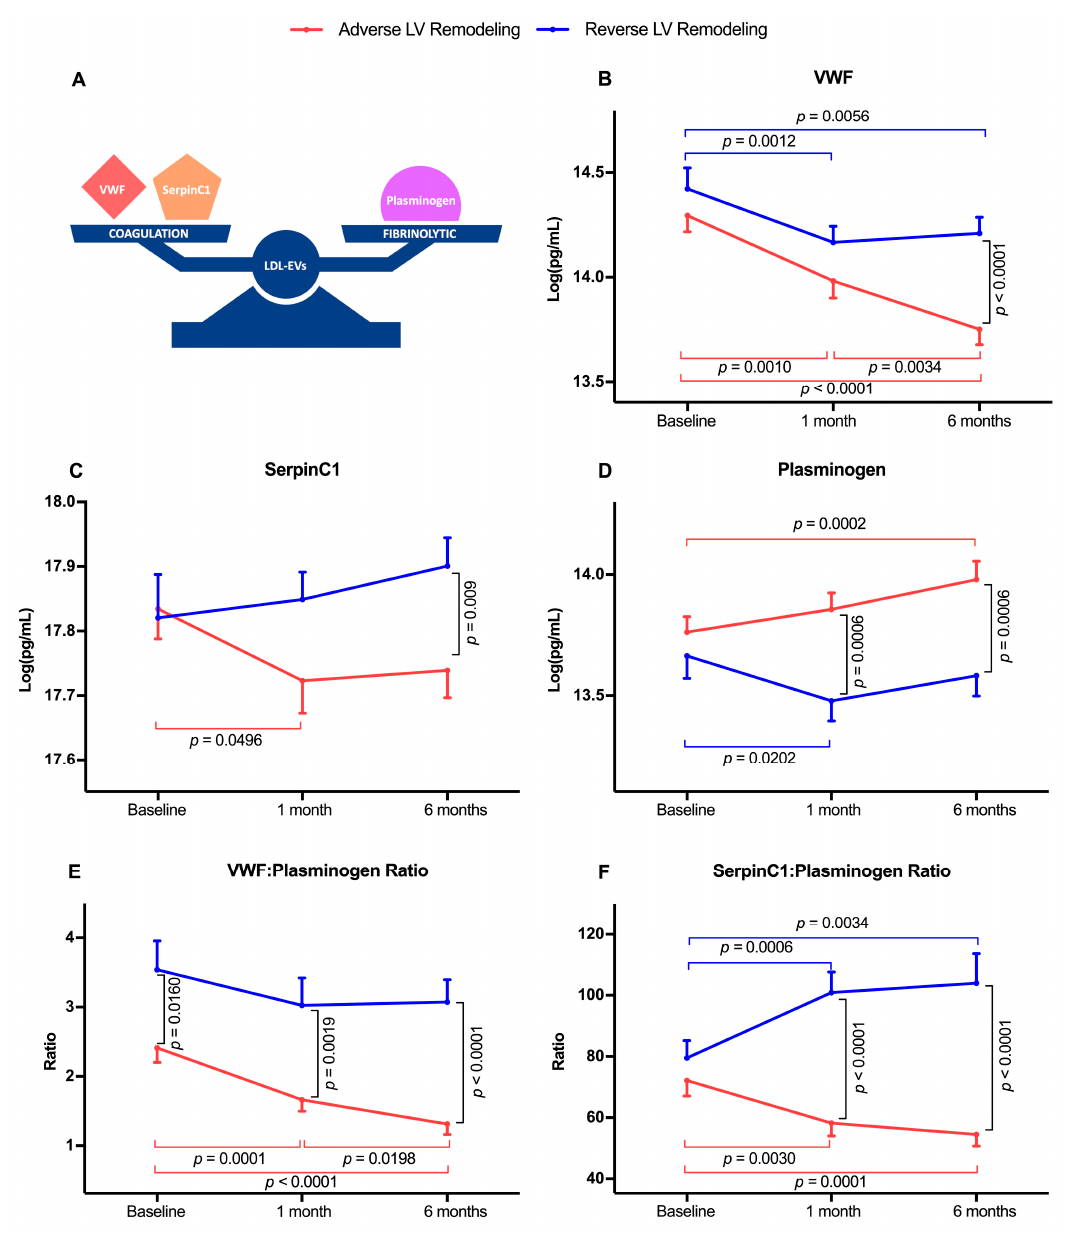
Figure 2. Temporal changes in LDL-EV hemostatic protein composition in post-AMI patients with adverse and reverse LV remodeling. Coagulation proteins (VWF, SerpinC1) and fibrinolytic protein (plasminogen) levels and their ratios (VWF:Plasminogen, SerpinC1:Plasmingen) in LDL-EVs of 198 post-AMI patients at baseline and after 1 and 6 month follow-up. ( A ) A diagram illustrating the studied hemostatic proteins in LDL-EVs. ( B – F ) Differences between baseline and follow-up measurements were established by Wilcoxon signed-ranked test (horizontal statistical bar). Differences in the three protein levels and the protein ratios between patients with adverse LV remodeling and reverse LV remodeling were established by Mann–Whitney U test (vertical statistical bar). Data are presented as mean ± SEM.